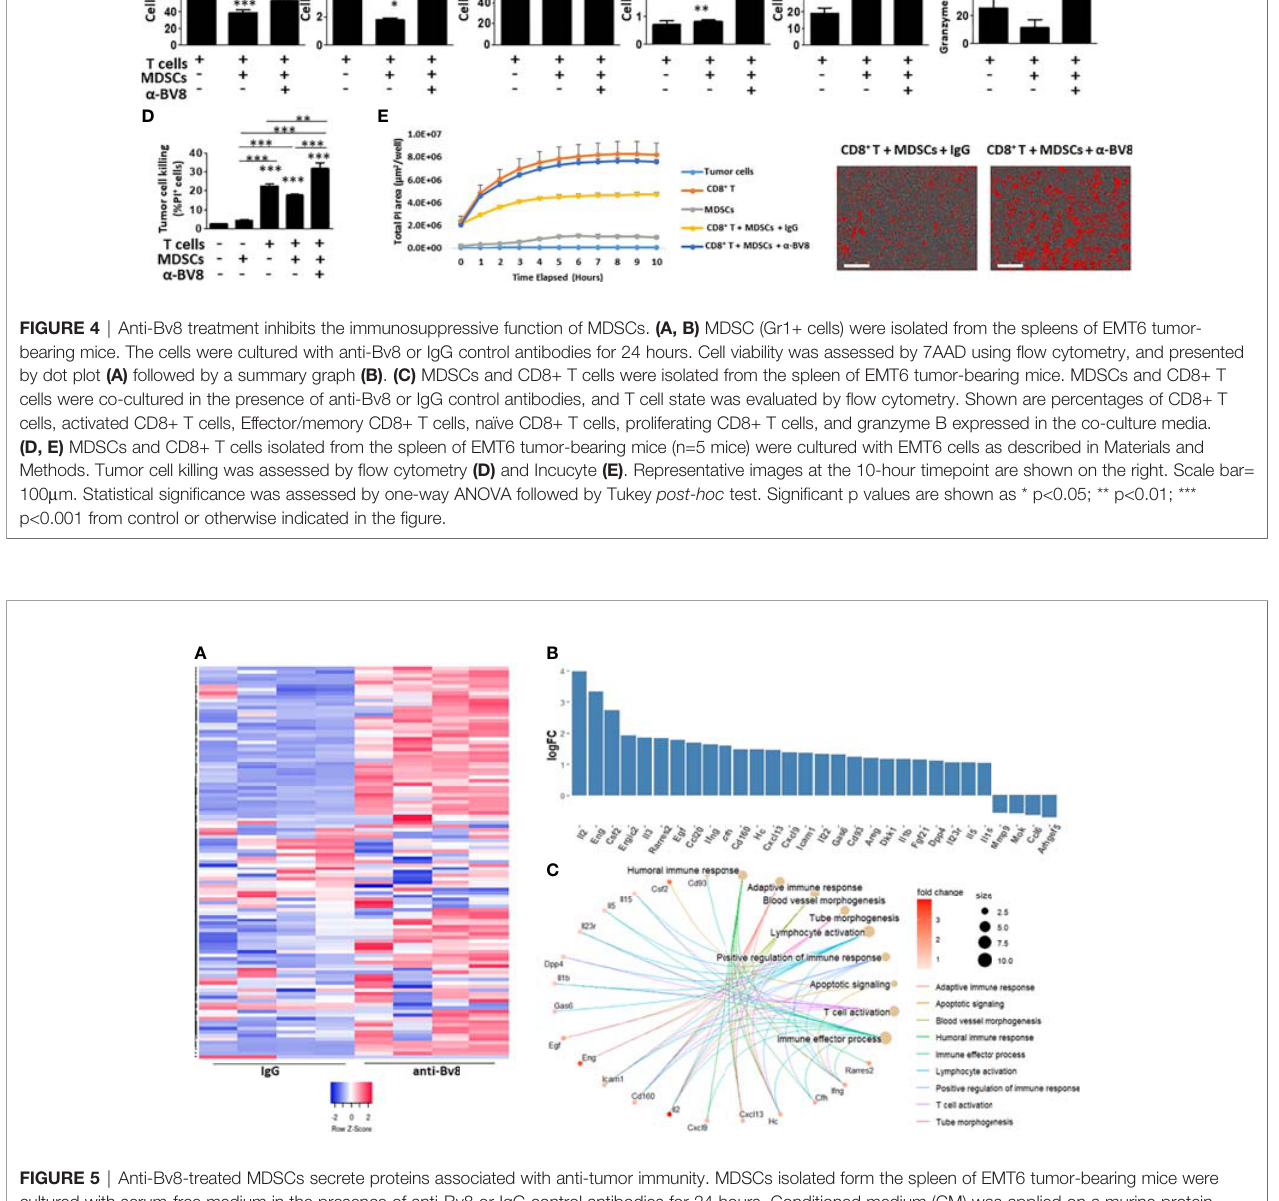
FIGURE 5 | Anti-Bv8-treated MDSCs secrete proteins associated with anti-tumor immunity. MDSCs isolated form the spleen of EMT6 tumor-bearing mice were cultured with serum-free medium in the presence of anti-Bv8 or IgG control antibodies for 24 hours. Conditioned medium (CM) was applied on a murine protein array to quantify the levels of ~110 proteins as assessed by densitometry. (A) A heatmap representing the total proteins measured in the arrays. (B) The relative levels of selected proteins, plotted as a Log fold change (anti-Bv8 vs IgG treatment). (C) Selected proteins (log2FC>0.5) representing immunological biological processes were visualized by R package clusterPro fi ler. The size of the bubble represents the number of proteins involved in each biological pathway and the color of the bubble represents the fold change in the protein expression level.